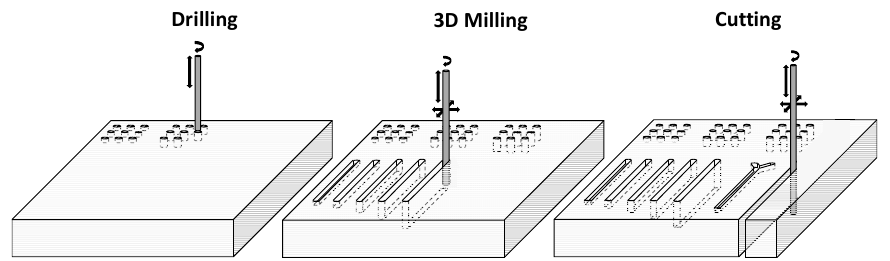
Figure 2. A graphic highlighting 3D drilling, milling, and cutting machining operations performed on the same glass substrate.